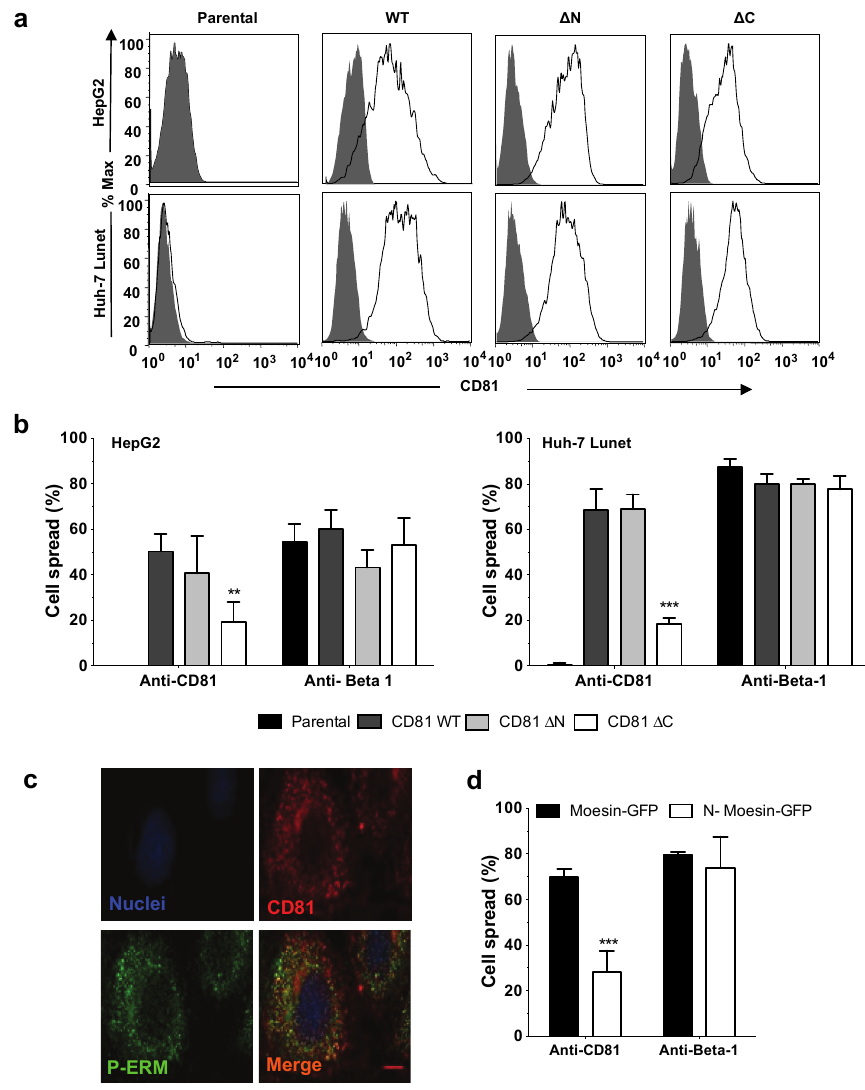
Figure 4. CD81 C -terminal-dependent hepatoma spread and role of actin-associated Ezrin-Radixin-Moesin (ERM) in CD81-dependent hepatoma spread. Flow cytometric detection of CD81 (2s131, 5 µg/mL) in HepG2 or Huh-7 Lunet cells transduced to express non-tagged CD81 , CD81 or CD81 , where filled histogram depicts irrelevant IgG WT Δ N Δ C control ( a ). Percentage spread of HepG2 or Huh-7 Lunet cells transfected to express CD81 , CD81 or CD81 following anti-CD81 (1s262) or anti-Beta-1 (5 µg/mL) WT Δ N Δ C ligation for 6 h (HepG2.CD81) or 1 h (Huh-7 Lunet) ( b ). Confocal images depicting CD81 co-localization with phosphorylated ERM proteins in Huh-7.5 cells ( c ). Percentage spread of Huh-7.5 cells transfected to express Moesin-GFP or the dominant negative N-Moesin-GFP following anti-CD81 (1s262, 5 µg/mL) or anti-Beta-1 (5 µg/mL) ligation for 1 h ( d ). Data presented are from an individual experiment representative of at least three independent experiments, *** p ≤